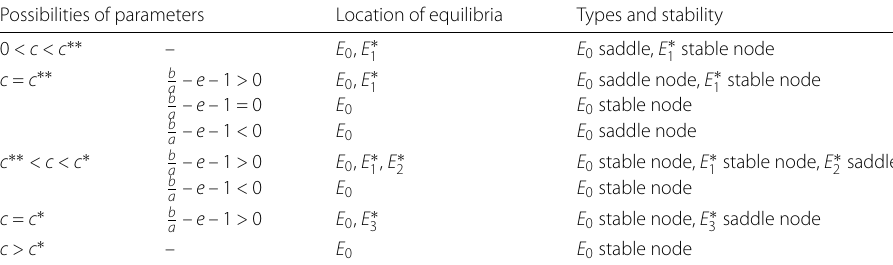
Table 1 Equilibria of system (1.7) in finite planes Possibilities of